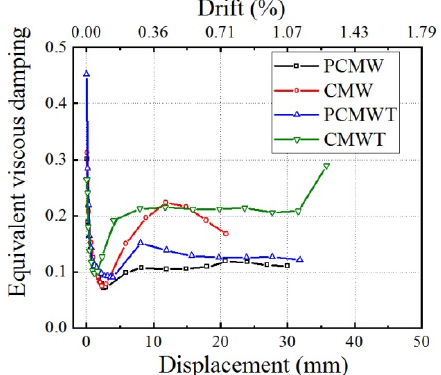
Figure 13. Equivalent viscous damping of the tested walls.